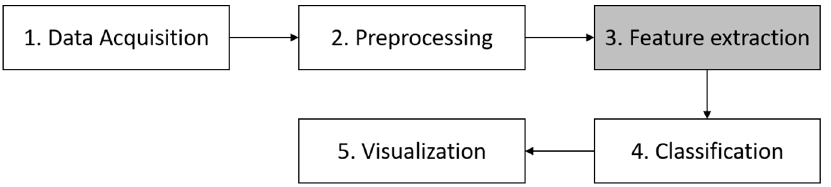
Figure 1. Overall system architecture for paved and unpaved road classification.